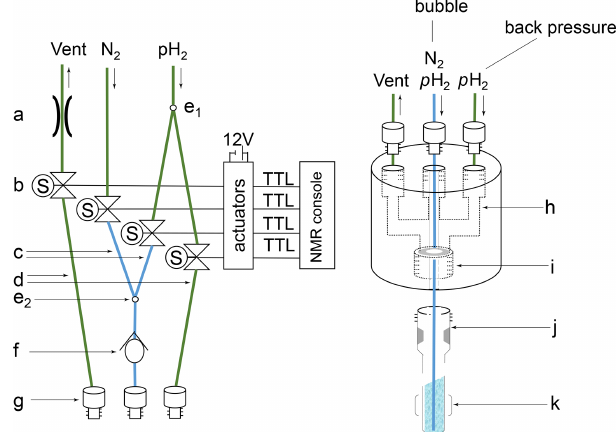
Figure A1. Schematic representation of the gas–liquid reaction set-up. Left: (a) variable pressure relief valve, set to 4bar; (b) solenoid valves controlled via TTL lines powered by an external 12V source and timed via trigger commands in the pulse sequence taking care of a controlled supply of nitrogen and para-hydrogen as described in Sect. 2.2 and 2.3; (c) 1 / 16 (cid:48)(cid:48) O.D. PEEK tubing with 0.010 (cid:48)(cid:48) I.D. (blue); (d) 1 / 16 (cid:48)(cid:48) O.D. PEEK tubing with 0.030 (cid:48)(cid:48) I.D. (green); (e) Y splitter: ( e 1 ) splitting 5bar p-H 2 source into a “bubble” and a “back pressure” line, ( e 2 ) combining 5bar N 2 and p-H 2 sources into a joined bubble line; (f) check valve; (g) tube fitting UNF 10-32 connectors. Right: (h) headpiece connecting the PEEK tubing holding the 7 (cid:48)(cid:48) thin wall QPV NMR tube; (i) UNF 7/16-20 thread holding the QPV NMR tube – using a 2mm silicon disc on top of the tube to close off the system; (j) Wilmad 7 (cid:48)(cid:48) thin wall QPV NMR tube; (k) area of detection with the bubble line centered down to the bottom of the NMR tube.